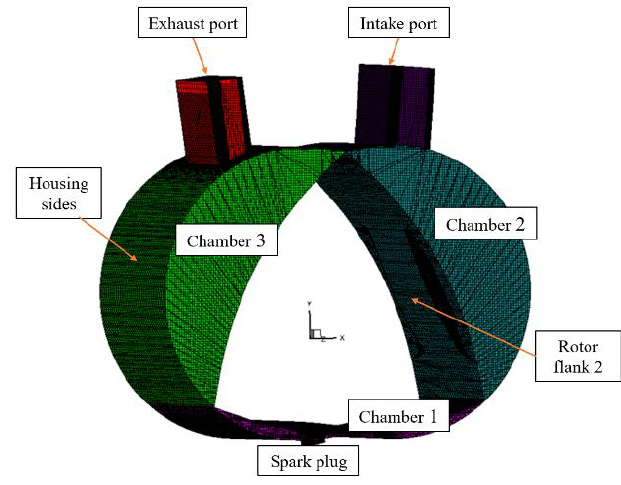
Figure 5. Schematic illustration of the test engine surfaces.